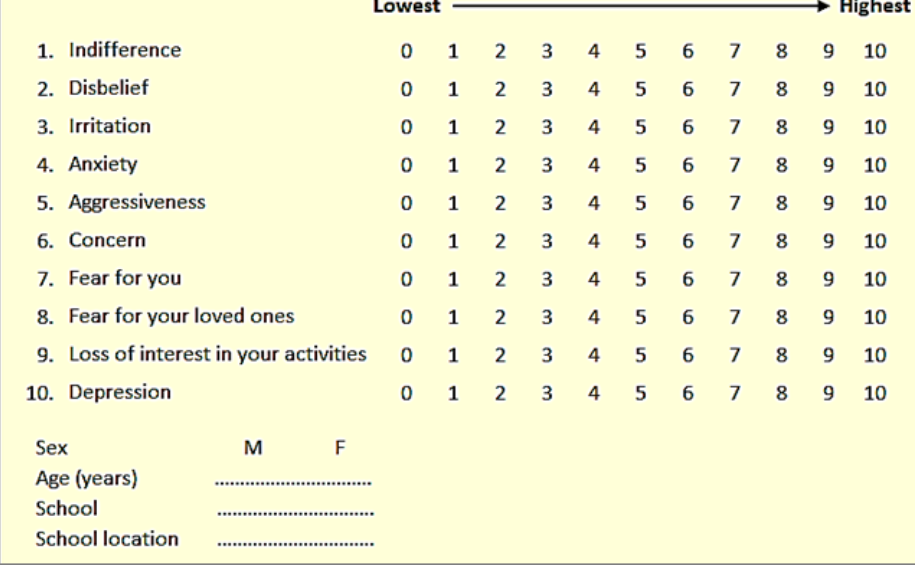
Figure 1. This is a figure. Schemes follow the same formatting. Figure 1. The questionnaire with all variables